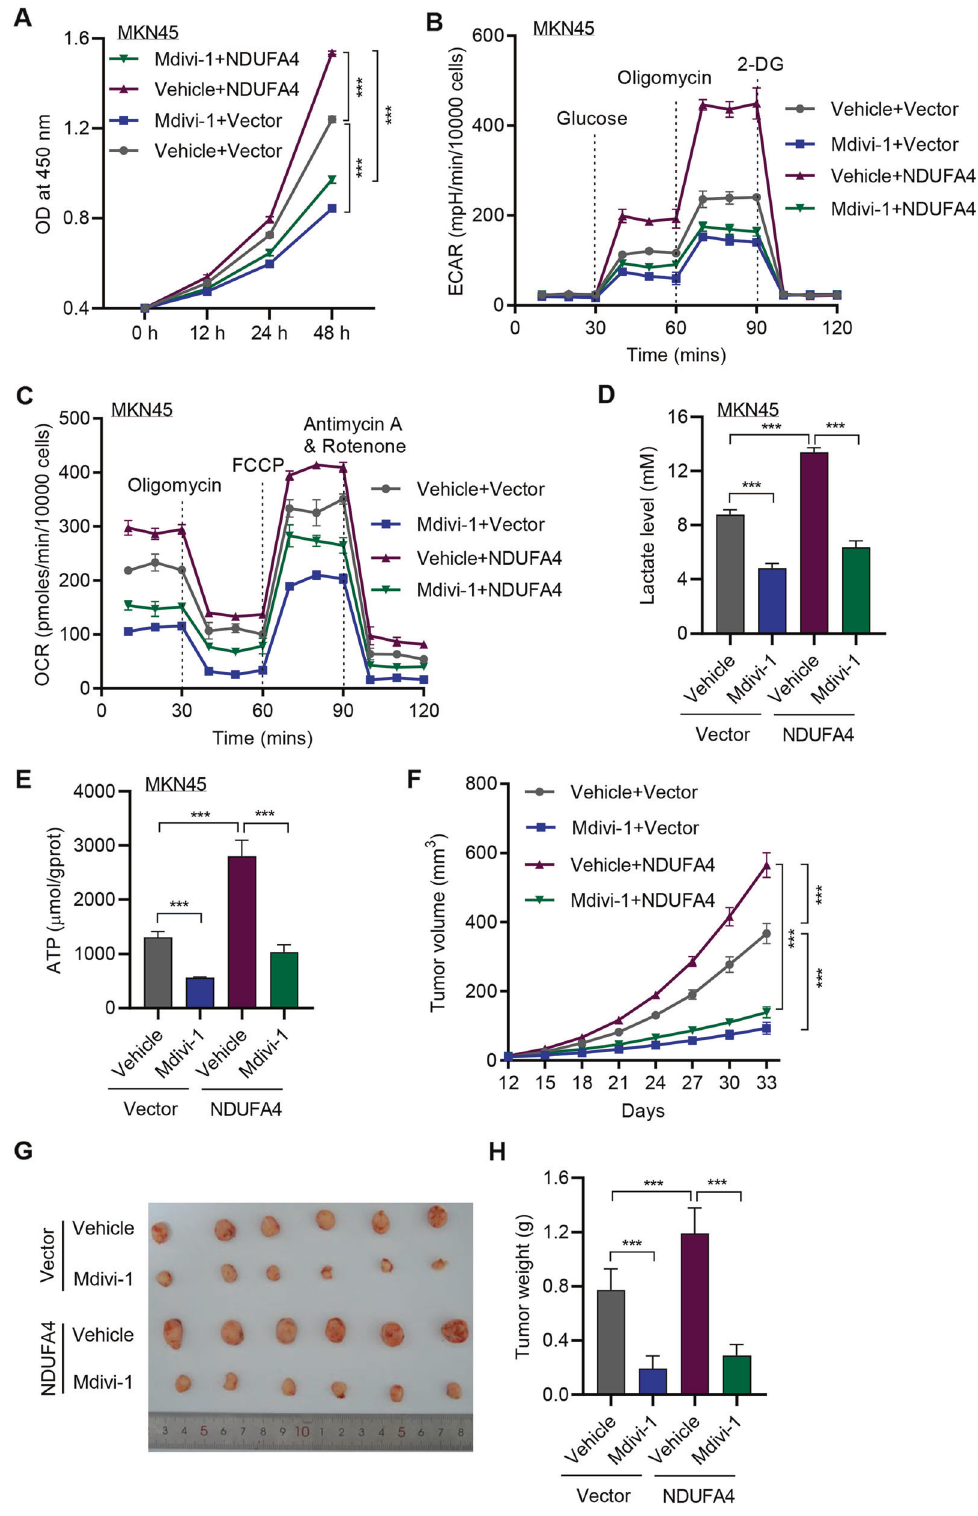
Fig. 7 Inhibition of mitochondrial fi ssion reversed NDUFA4-mediated effects in GC. A Cell viability, ( B ) ECAR, ( C ) OCR, ( D ) lactate and ( E ) ATP content of MKN45 cells with NDUFA4 overexpression and/or 20 μ M Mdivi-1. MKN45 cells transduced with NDUFA4 expression vector were subcutaneously injected into the armpits of the mice with or without 25 mg/kg Mdivi-1 treatment. F Tumor volume in each group. G The photograph of xenografts. H Tumor weight in each group. *** P <